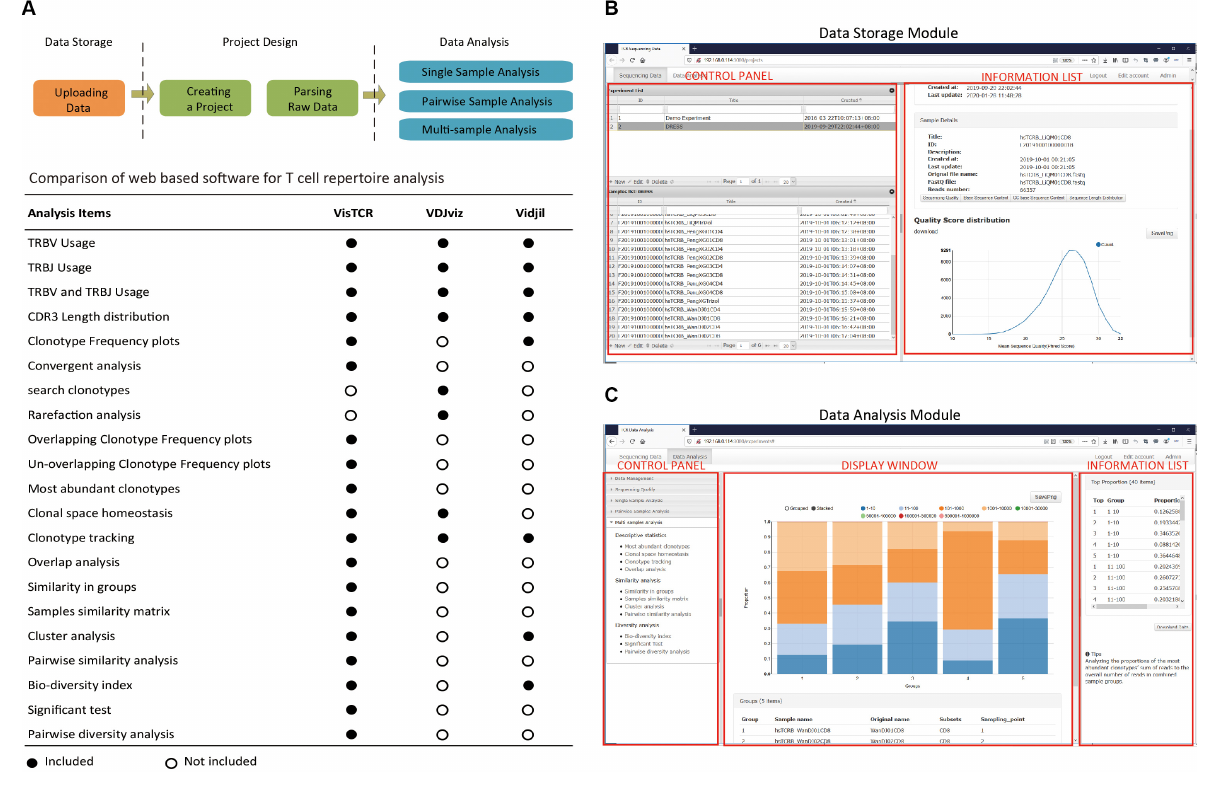
FIGURE 1 | Overview of the VisTCR software. (A) Basic workflow of the VisTCR software and TCR sequencing data analysis methods in VisTCR software. The workflow of the VisTCR software includes three steps (1) Uploading TCR sequencing data files in the Data Storage Module, (2) Creating an analysis project in the Data Analysis Module. (3) Performing analysis and obtaining results in the Data Analysis Module. (B) The GUI of the Data Storage Module. (C) The GUI of the Data Analysis